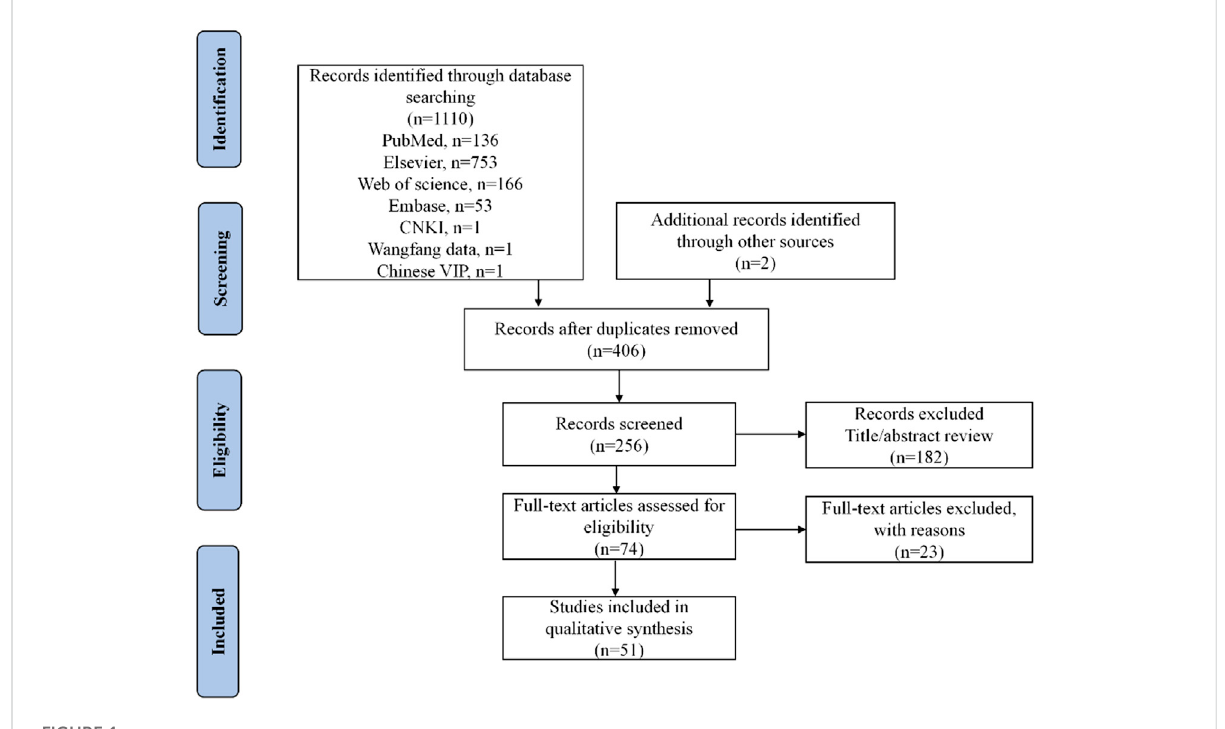
FIGURE 1 Flow diagram of the selection of studies for